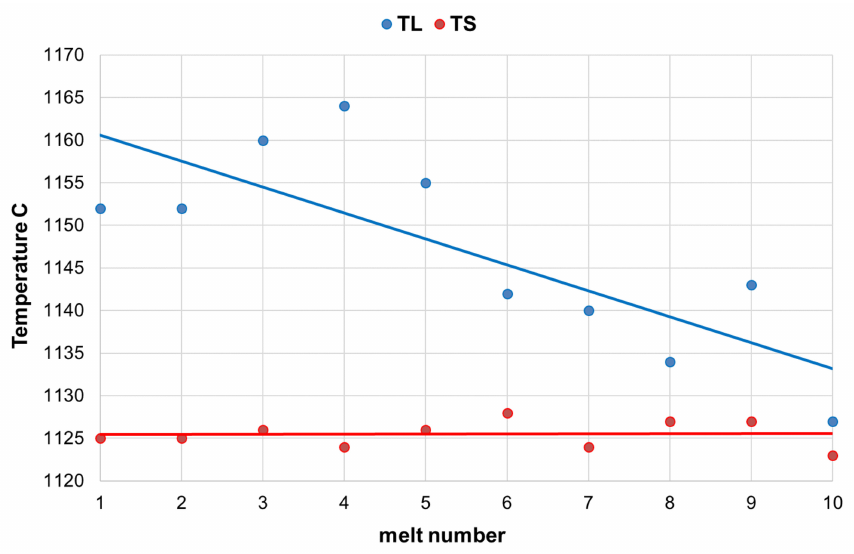
Figure 1. Impact of SiC content (increase of additive in subsequent melts) on liquidus TL and solidus TS temperature.